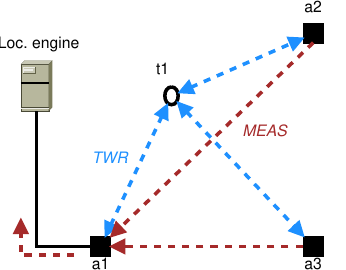
Figure 1. Positioning system composed of a single cell that contains 3 anchors.